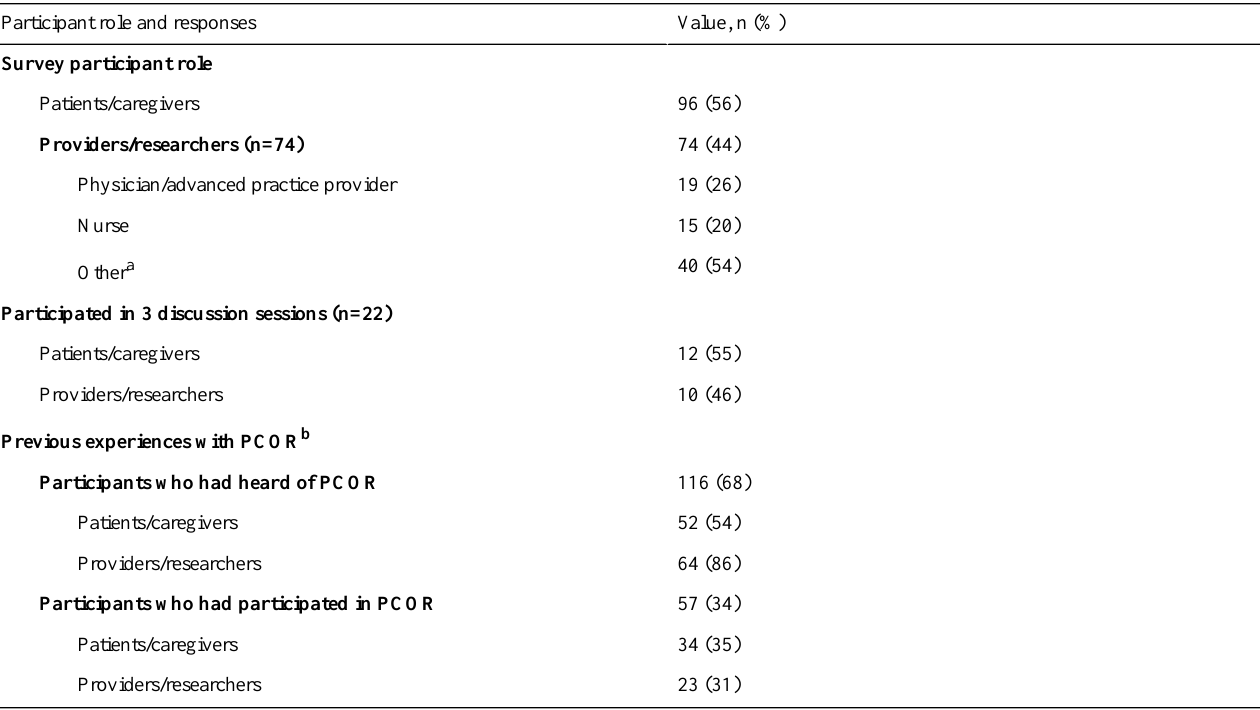
Table 1. Participant roles and survey responses